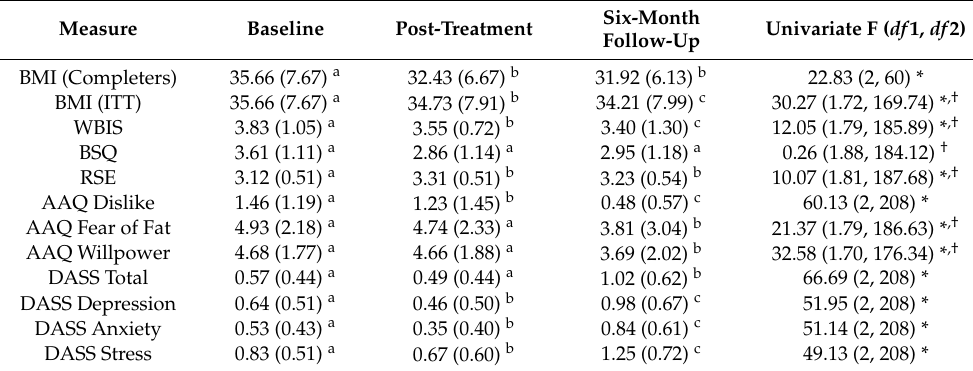
Table 1. Mean scores of all study measures.